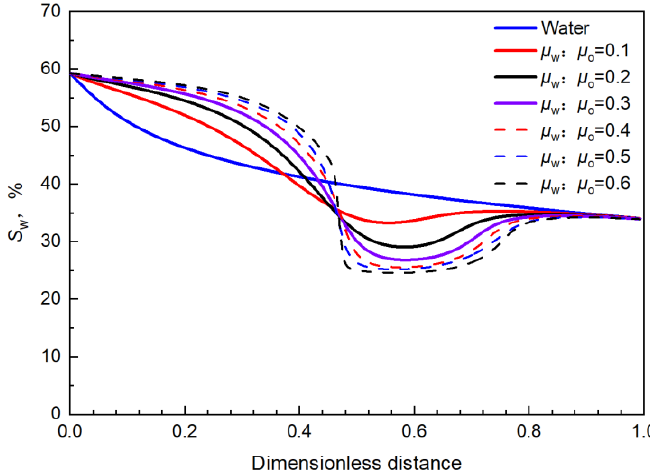
Figure 17. Comparison of water saturation distribution along the flow under different water-oil viscosity ratio conditions.